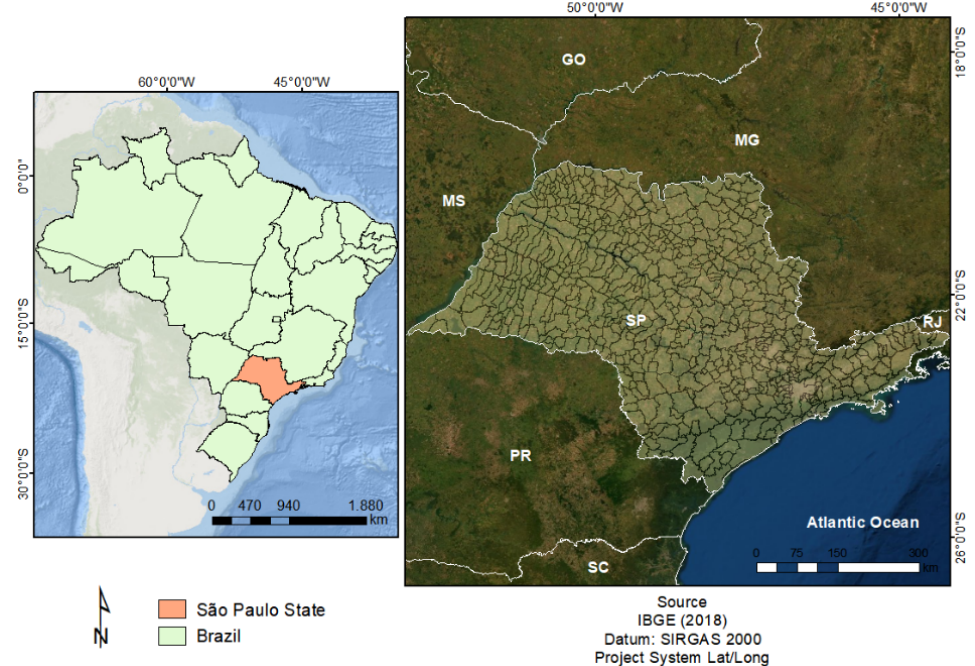
Figure 1. Location of the São Paulo state and its 645 municipalities.